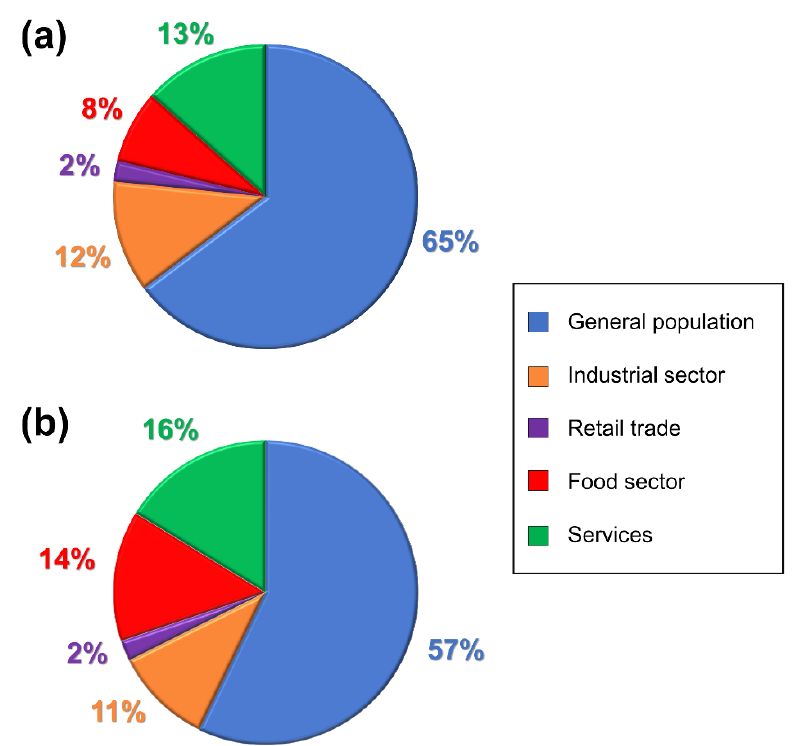
Figure 5. Pie charts showing the production rates of wastes from different sectors regarding masks in the whole year 2020 ( a ) and gloves in the period of phases 1 and 2 ( b ).